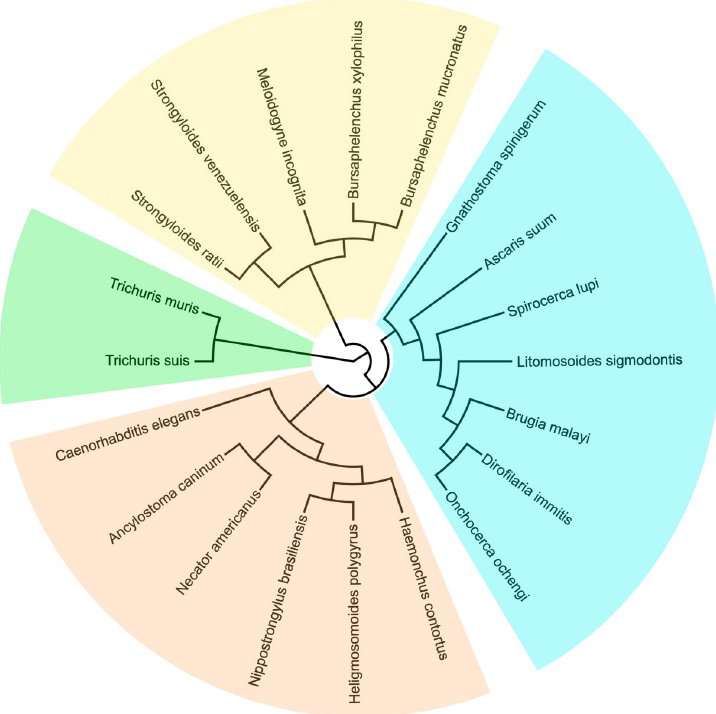
Fig 1. Helminth phylogeny. The 20 selected species are placed along the nematode clades containing parasitic species according to recent phylogenetic analyses [34,61,62]. Trichuris spp. populate clade I (green); clade III (blue) contains the filarial nematodes, S . lupi , A . suum , and G . spinigerum ; clade IV (yellow) contains Strongyloides spp. and the selected plant parasites; clade V (orange) contains C . elegans and other